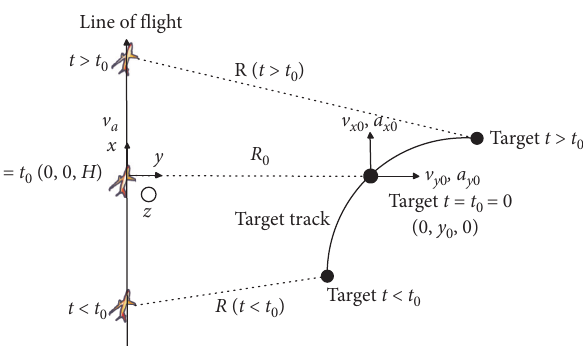
Figure 1: Target and radar geometry for the airborne case